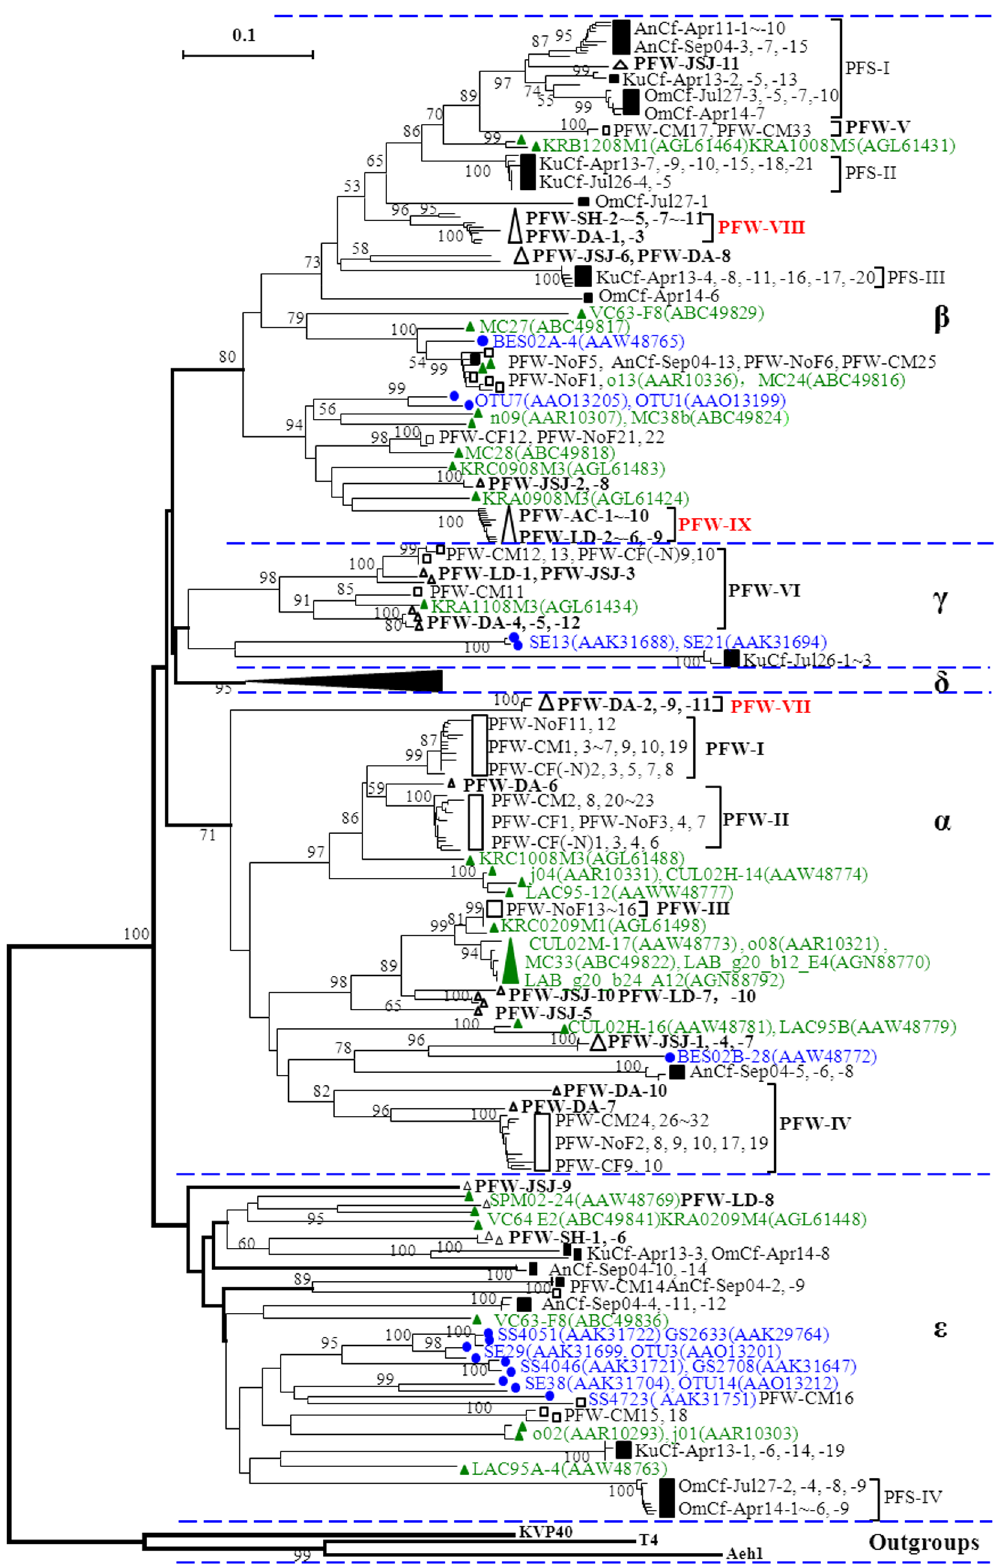
Figure 2. Neighbor-joining phylogenetic tree showing the relationships of g20 amino acid sequence from paddy floodwaters in NE China with from those from lake freshwaters (Dorigo et al. 2004; Short and Suttle 2005; Wilhelm et al. 2006; Zhong and Jacquet 2013; Yeo and Gin, unpublished data which were submitted in Jan 15, 2013), paddy floodwaters in Japan (Wang et al. 2010), paddy field soils in Japan (Wang et al. 2011) and marine waters (Fuller et al. 1998; Zhong et al. 2002; Marston and Sallee 2003; Wang and